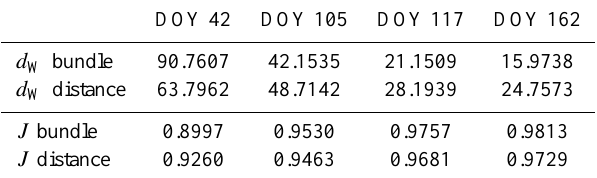
Table 4. Values of the Wasserstein distance d W between the cdf of the truth and the optimised cdfs. Values of the Jaccard similar- ity index J between the soil moisture image of the truth and the images corresponding to the optimised cdfs. The optimisation is performed w.r.t. the information present in the bundle (bundle) or w.r.t. the Wasserstein distance between the empirical and the cen- tral cumulative normal distribution in the bundle